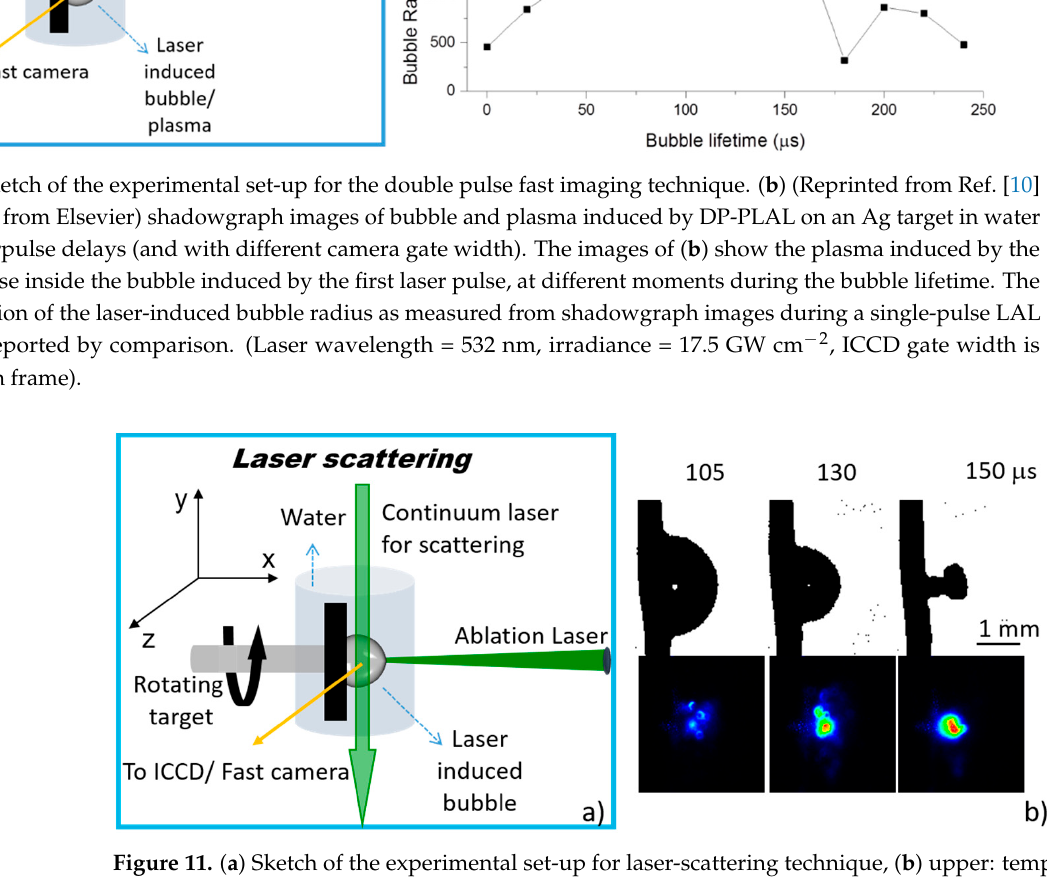
Figure 10 . ( a ) Sketch of the experimental set-up for the double pulse fast imaging technique. ( b ) (Reprinted from Ref. [10] with permission from Elsevier) shadowgraph images of bubble and plasma induced by DP-PLAL on an Ag target in water at different interpulse delays (and with different camera gate width). The images of ( b ) show the plasma induced by the second laser pulse inside the bubble induced by the first laser pulse, at different moments during the bubble lifetime. The temporal evolution of the laser-induced bubble radius as measured from shadowgraph images during a single-pulse LAL experiment is reported by comparison. (Laser wavelength = 532 nm, irradiance = 17.5 GW cm − 2 , ICCD gate width is re- ported on each frame).